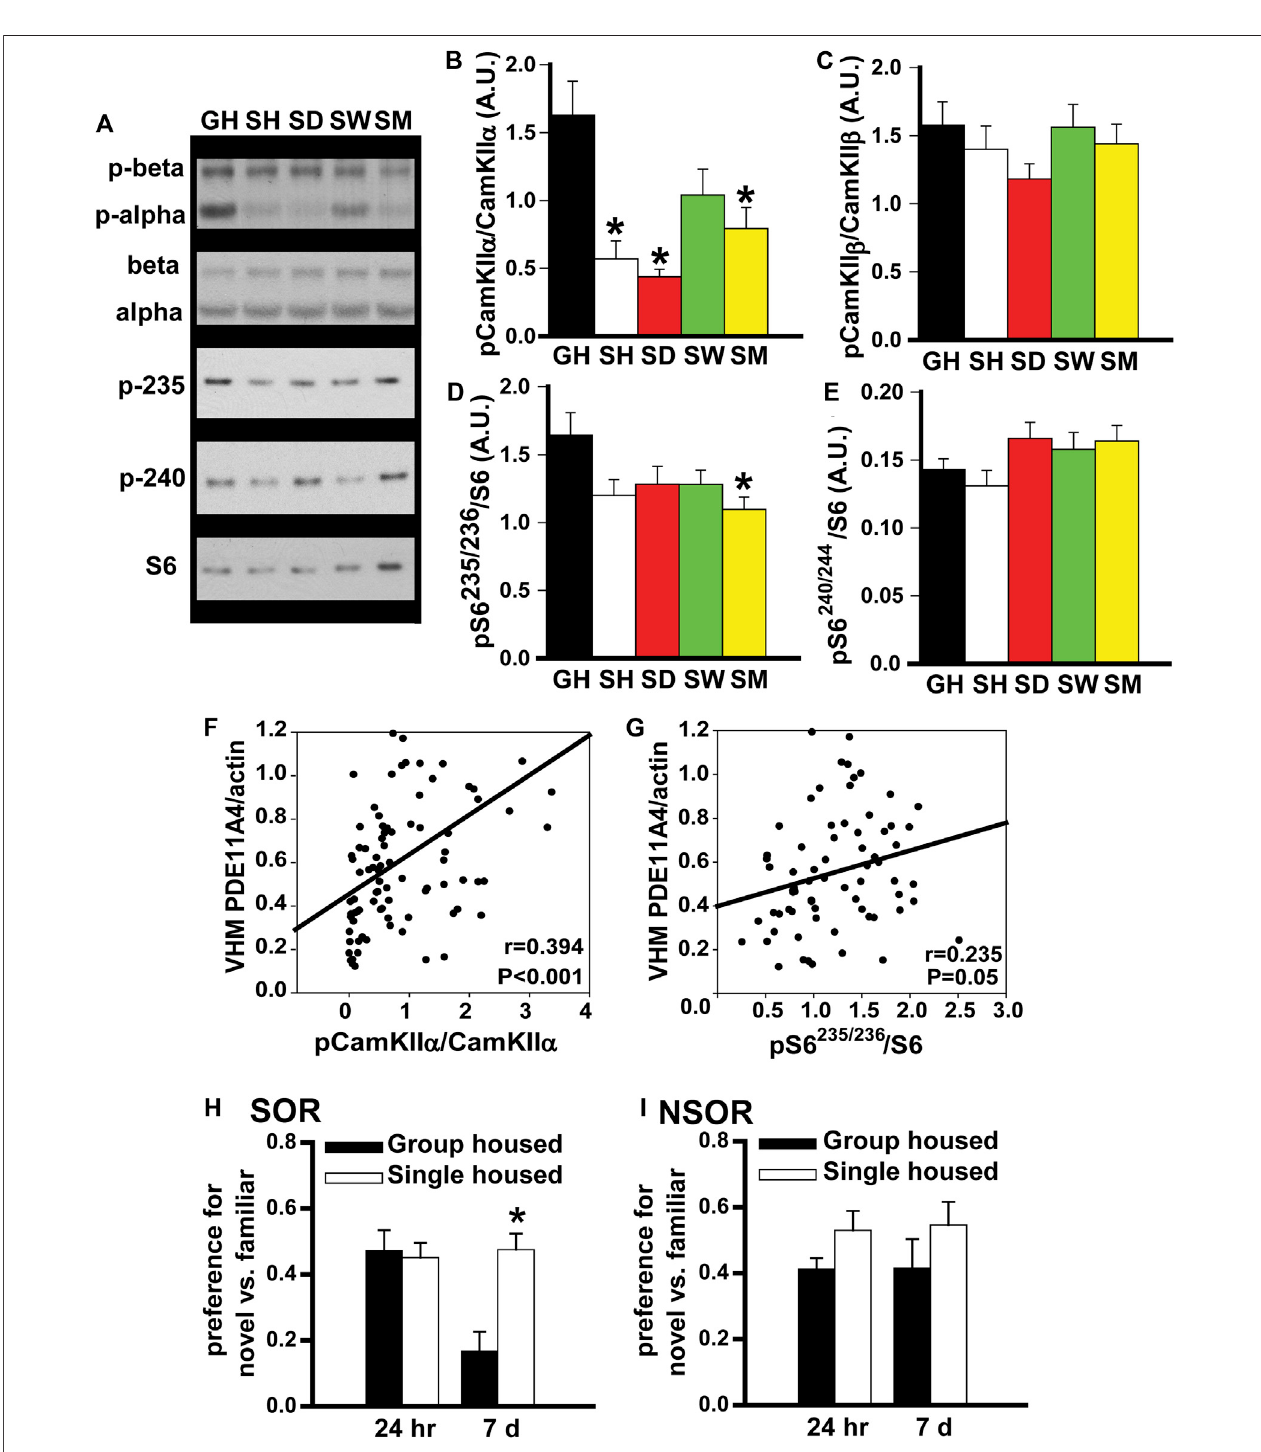
FIGURE 3| In adult mice, social isolation triggers changes in biochemical and behavioral endpoints that are consistent with reduced PDE11A4 activity. Previously, we reported PDE11A4 expression correlates with phosphorylation of CamKII α but not CamKII β and that deletion of PDE11A4 reduces phosphorylation of S6-235/236 butnotS6-240/244(Kellyetal.,2014;Hegdeetal.,2016a;Pilarzyketal.,2019).Thus,wedeterminedifsocialdeletionofPDE11A4reducesphosphorylationofS6-235/ 236 but not S6-240/244 [2; 3; 4]. Thus, we determined if social isolation would similarly affect these endpoints. (A) Consistent with the observed isolation-induced decreasesinPDE11A4describedabove,Westernblotsofadultgrouphousedmice(GH)andadultmicesingle-housedfor1 h(SH),1day(SD),1week(SW),or1month (SM)showthatsocialisolationsigni fi cantlydecreasesphosphorylationof (B) CamKII ⍺ (n (cid:2) 9 – 10samples/timepoint/sex).2-wayRMANOVAforallgroupsfailsnormality; however,separateanalysesforGHvs,SH,SD,andSMaswellasGHvsSWeachpassnormality(GHvsSH,SDandSMeffectofgroup:F(3,48) (cid:2) 11.83,FDR-P <